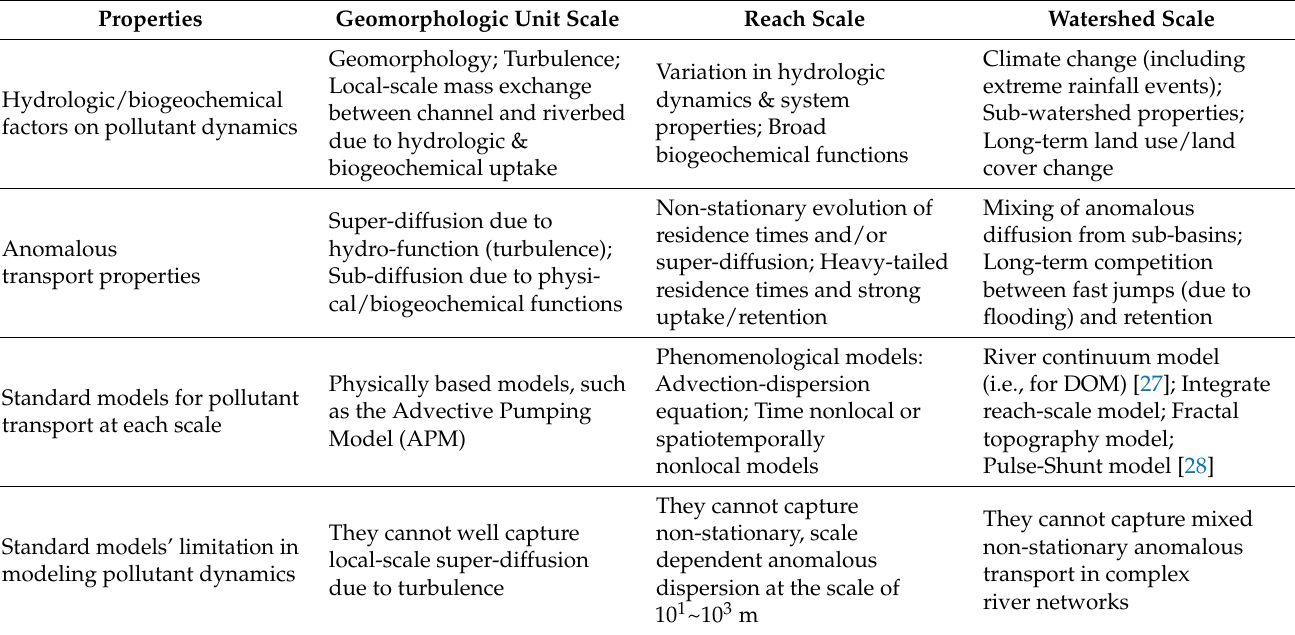
Table 1. Properties and standard models for pollutants moving at three representative scales in